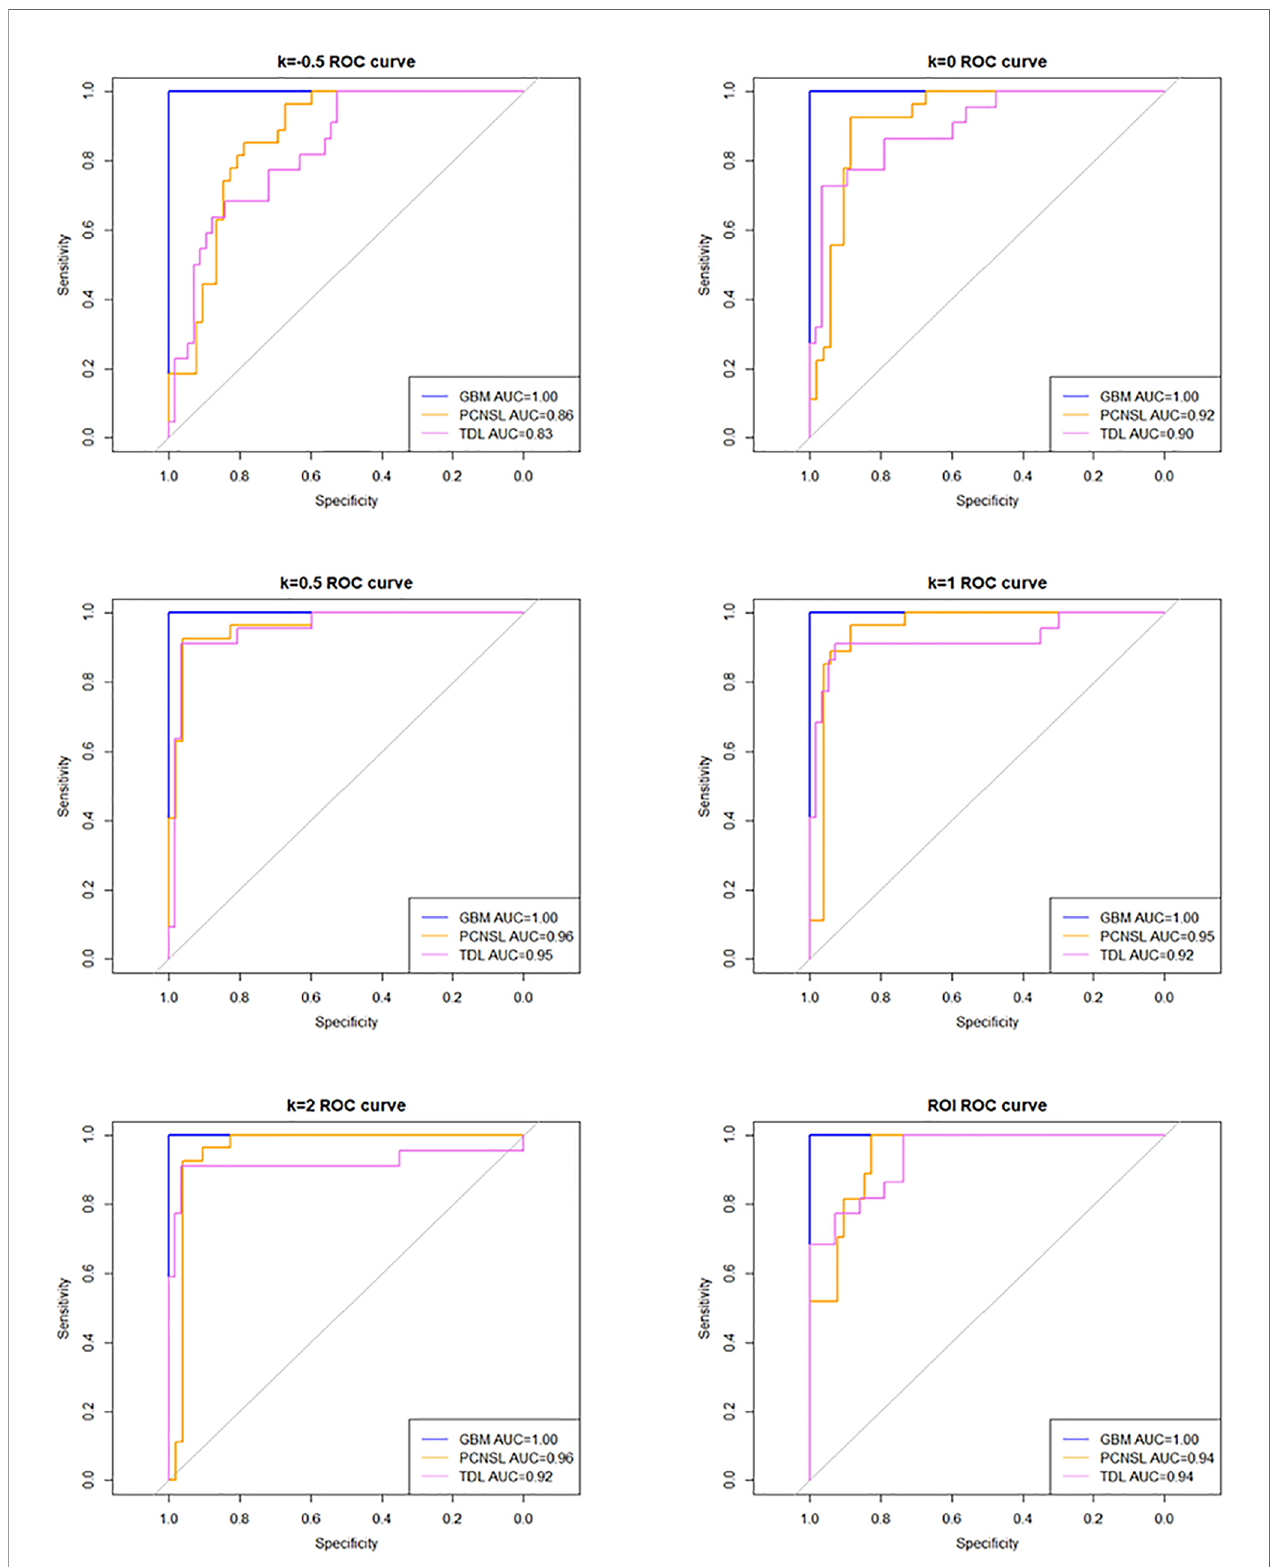
FIGURE 4 | Receiver operating characteristic (ROC) curve at different k values and region of interest